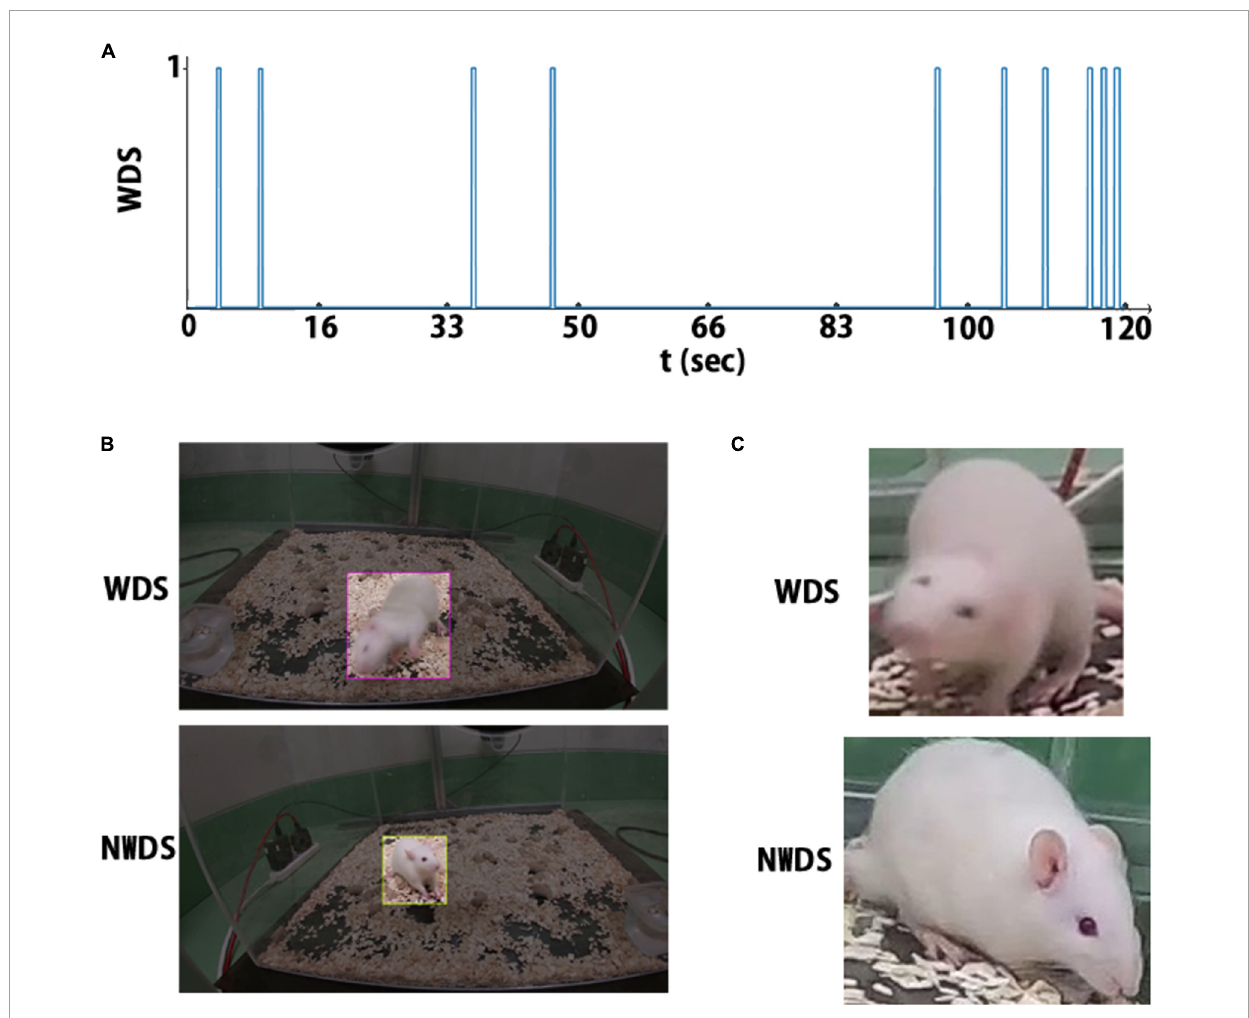
FIGURE3 There are three annotation types: (A) the rat behavior is labeled at each timestamp. (B) Label for object detection, region of interest, and behavior class. (C) cropped image and its corresponding behavior class label.